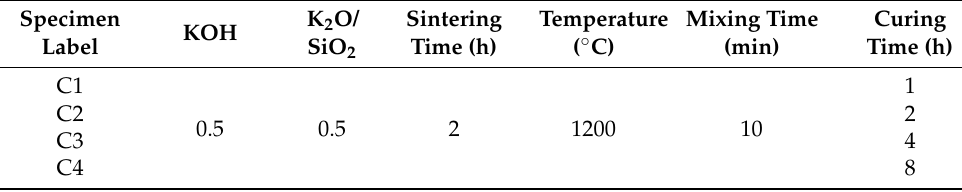
Table 6. Mixing proportion at different curing times.